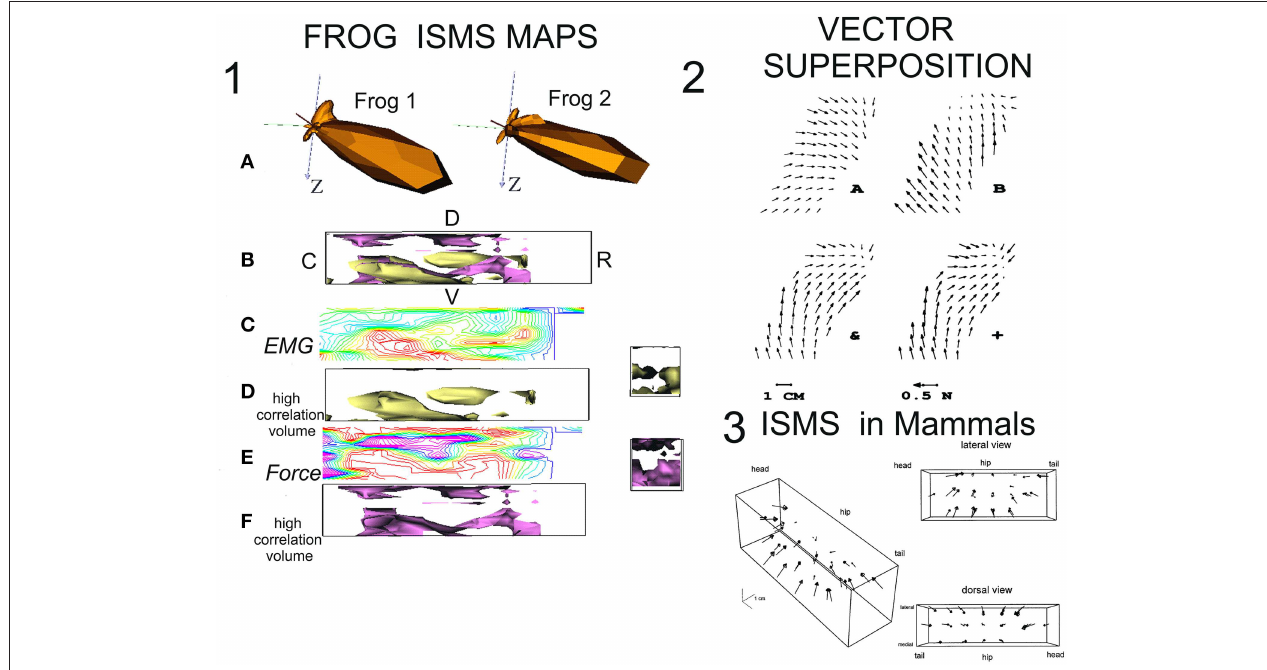
FIGURE 1 | Mapping of ISMS results and superposition in frogs and rats. (1) ISMS maps in lumbar spinal cord of spinal frogs. Redrawn from Giszter et al. (2000) with permission. (A) Polar spherical plots of the force directions recruited by ISMS. There is high similarity of 3D isometric ankle force recruitments across the spinal cords of two test maps in spinalized frogs. (B) 3D Map of lumbar cord with orientation and overlay of data in D and F (R-rostral; C-caudal; D-dorsal; V-ventral). The surfaces shown enclose regions of higher ISMS correlation between frogs. (C) A sample contour heat map of ISMS EMG (vector) recruitment correlation across the map in a sagittal plane at 400 microns from the midline. Red high, blue/magenta low. (D) Surface enclosing volumes of higher correlation interfrog regions in the ISMS EMG (vector) responses. (E) A sample